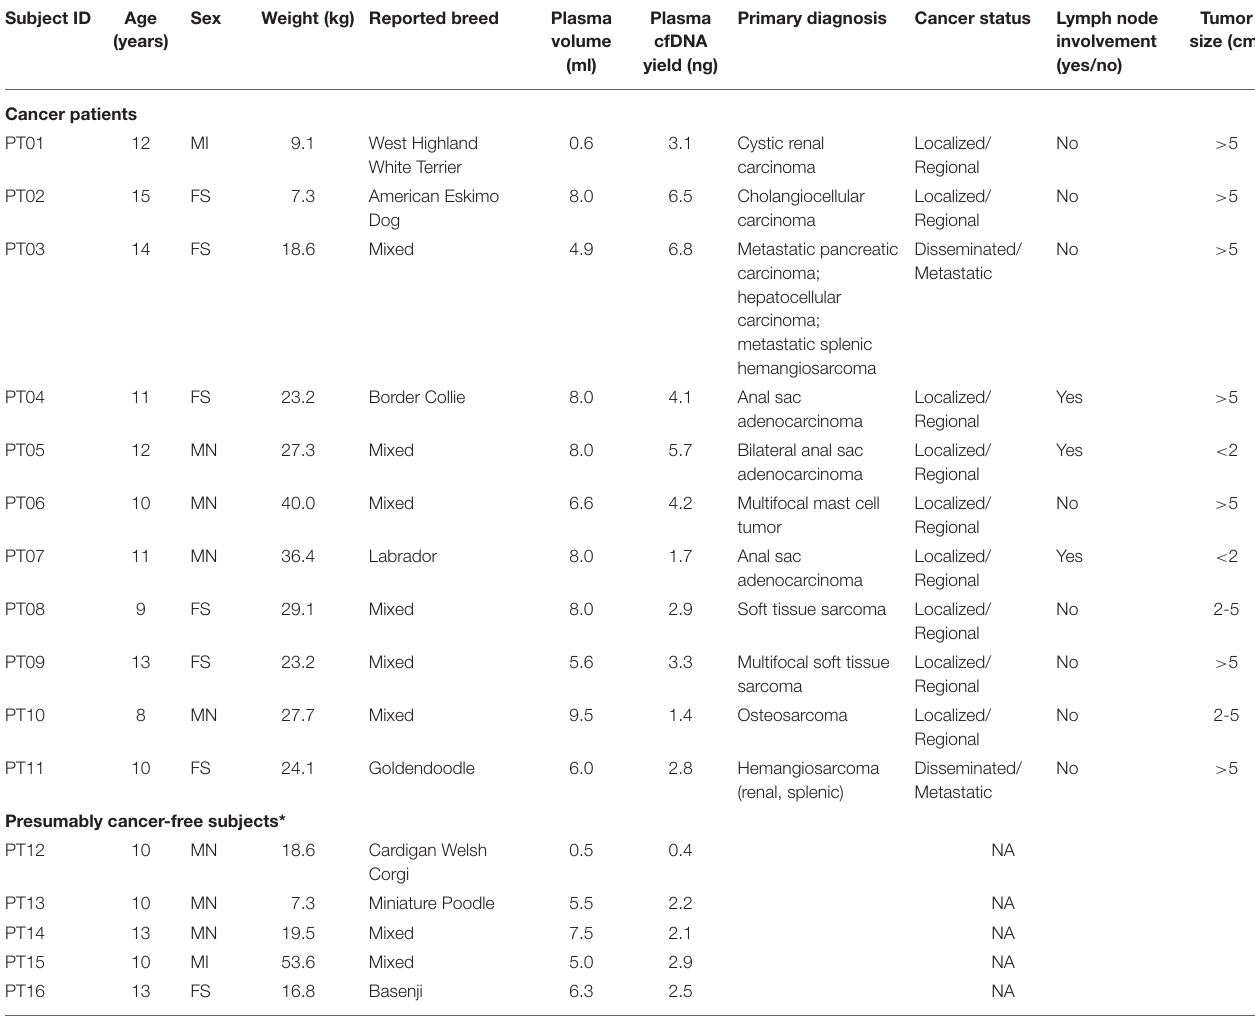
TABLE 1 | Patient demographics and clinical